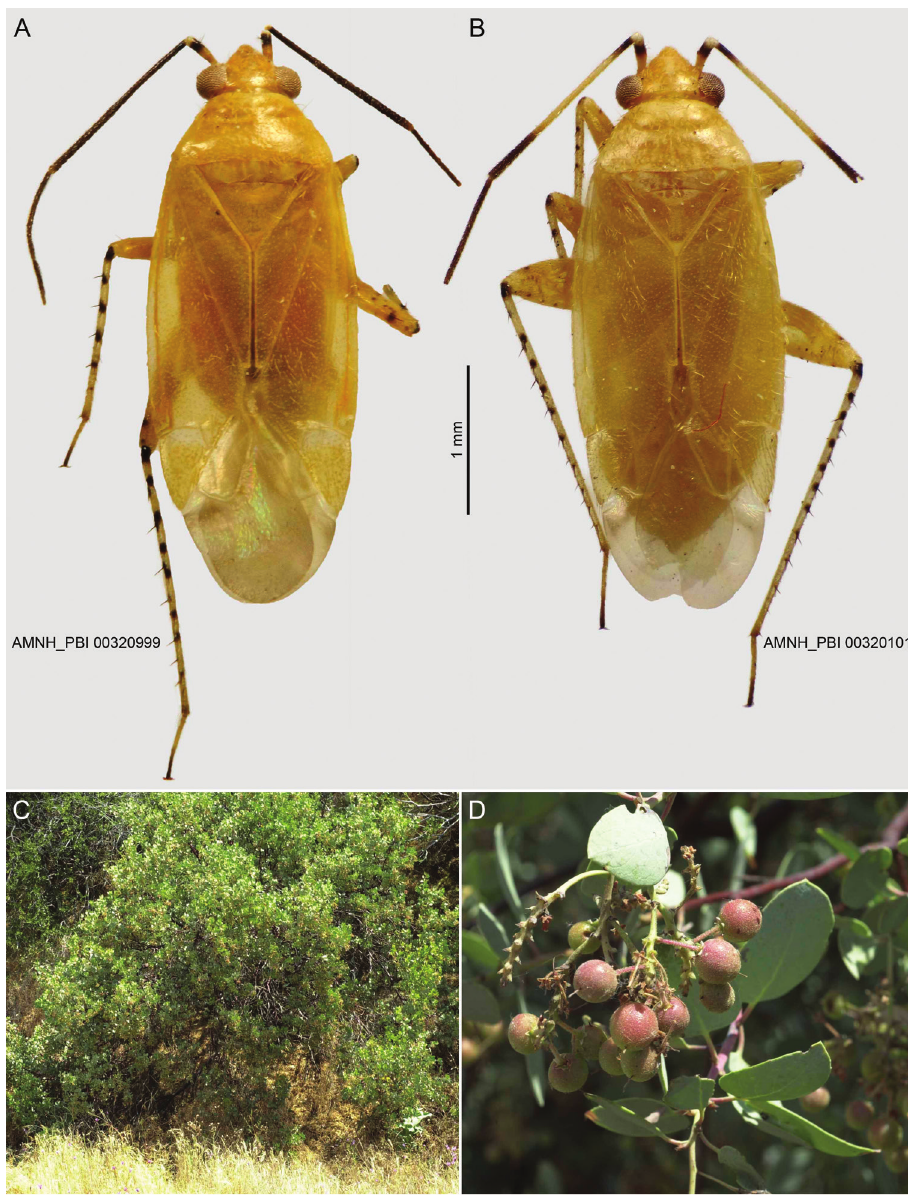
Figure 1. Habitus and hosts of Henryognathus thomasi. A Male B Female C–D Arctostaphylos viscida , California: Tulare Co.: NE of Springville on Bear Creek Rd near Scicon, 36.21394°N, 118.7716°W.